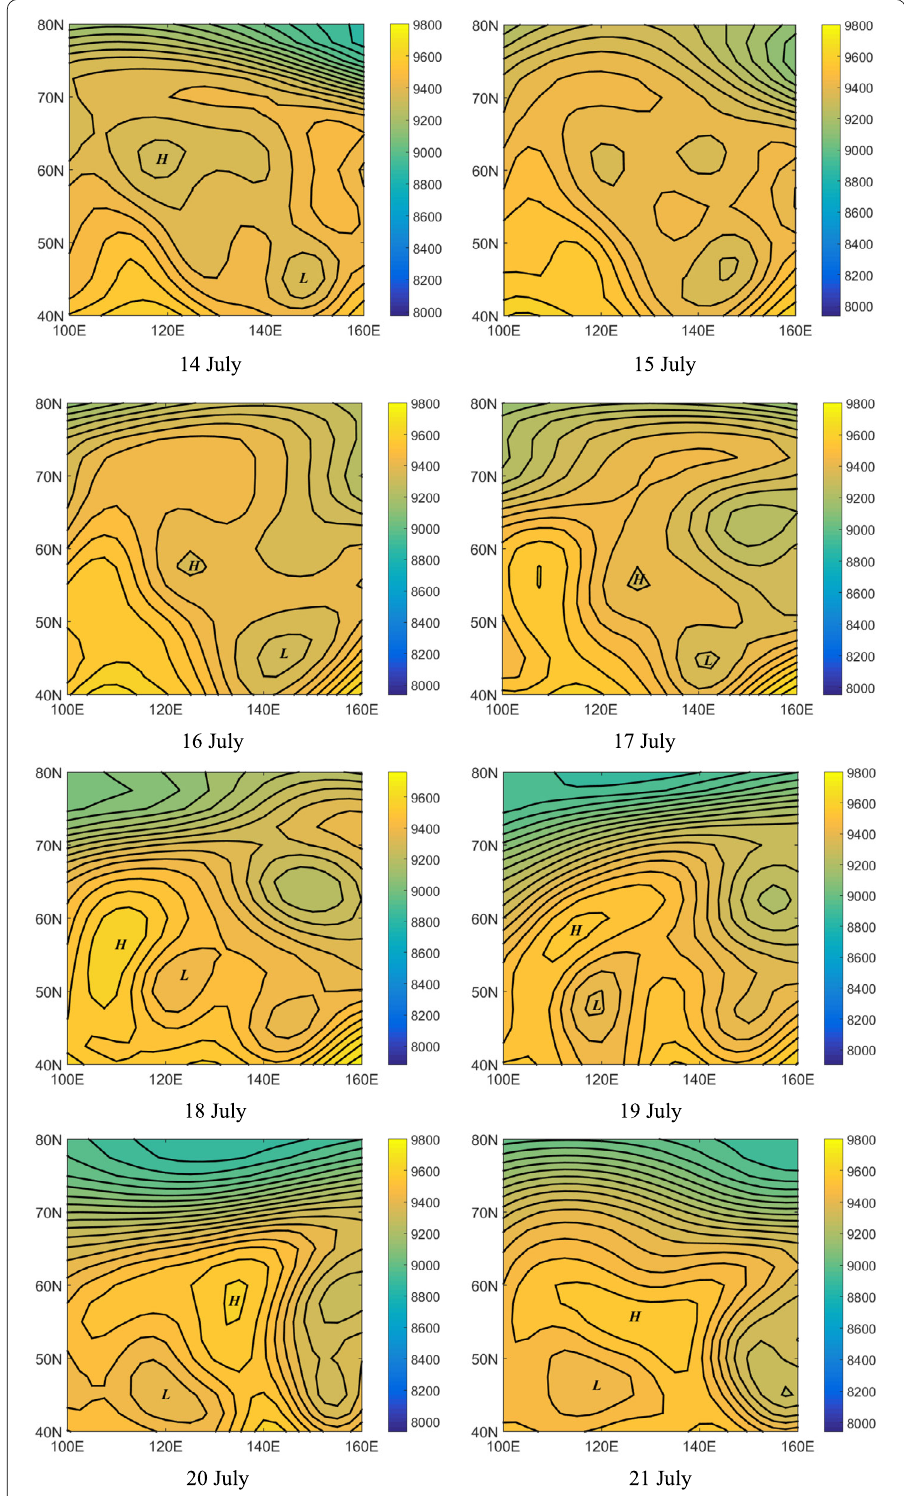
Figure 3 Geopotential height at 300 hPa pressure level of a blocking case during 14 July 2003 to 27 July 2003. Contour interval is 4 gpdm. The x axis is longitude and the y axis is